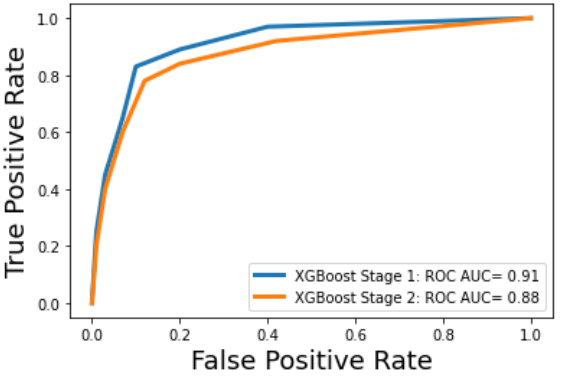
Figure 5. ROC curves for the optimal machine learning model in stage 1 and stage